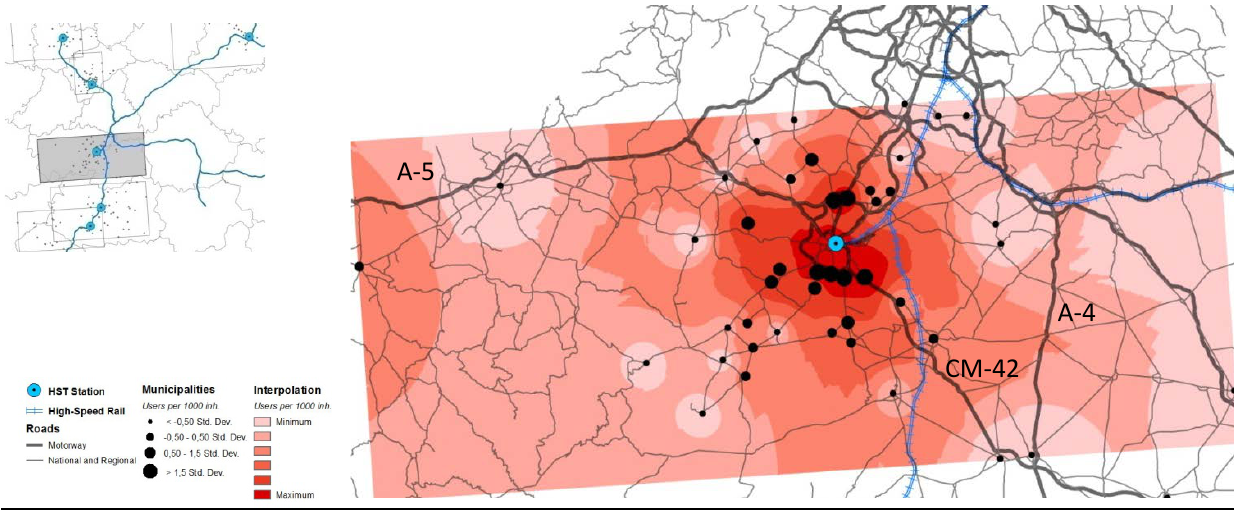
Figure 8. Toledo’s catchment